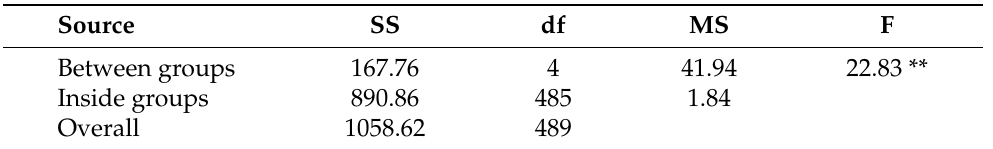
Table 2. ANOVA summary of the variable “degree of aesthetic preference” depending on the degree of regularity of the composition. Source SS df MS F Between groups 167.76 Inside groups 890.86 1.84 Overall 1058.62